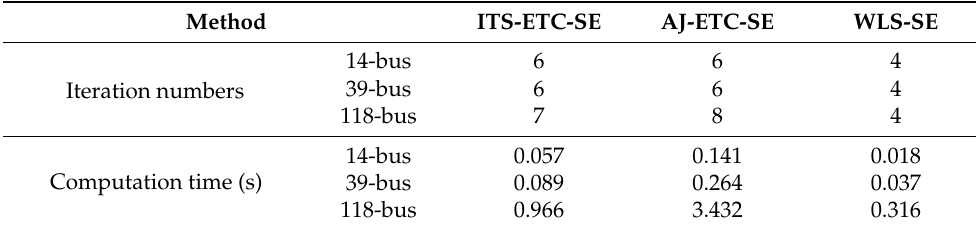
Table 4. Comparison of iteration numbers and computation time.